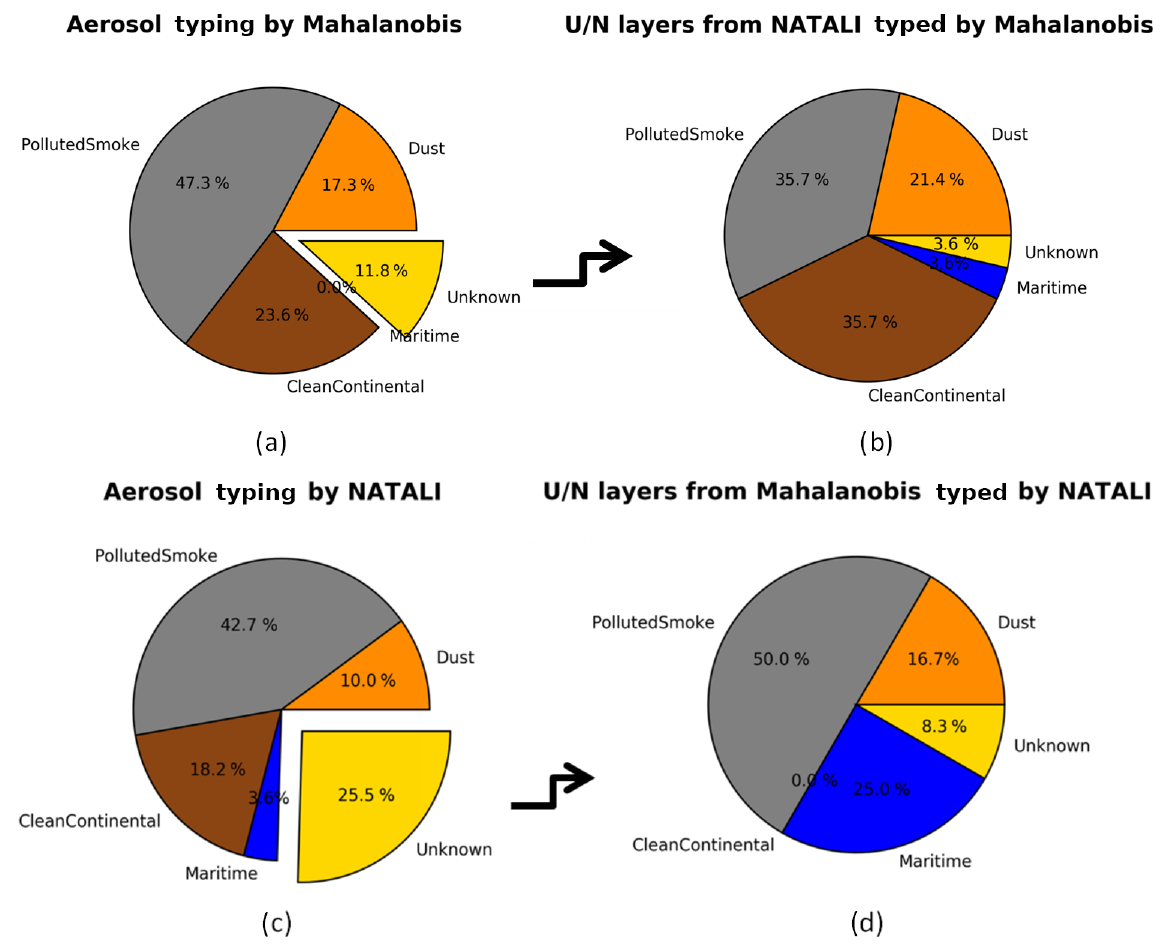
Figure 4. Percentages of typed and untyped layers for both automated